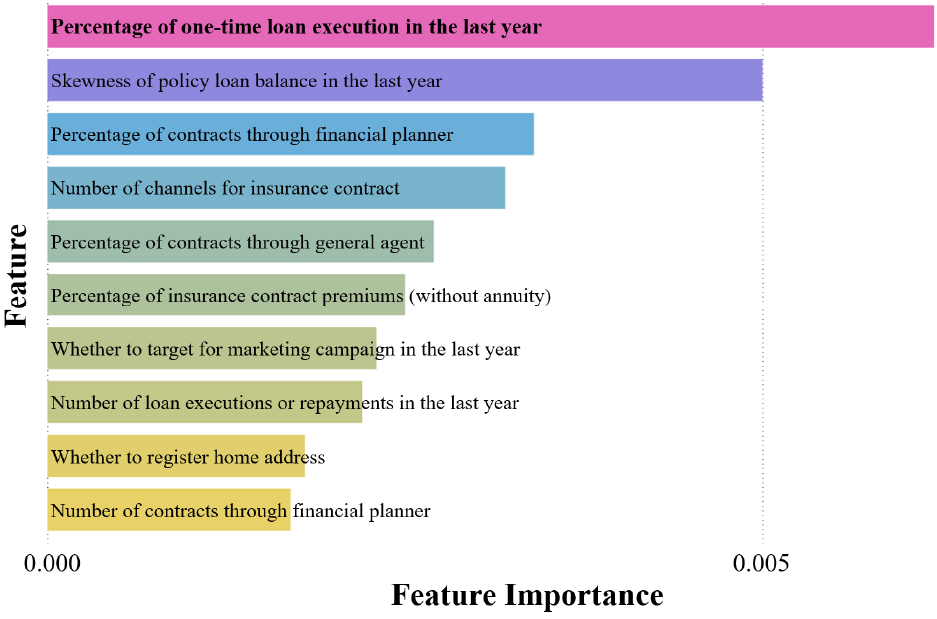
Figure 7. Top 10 important features in deep learning model.